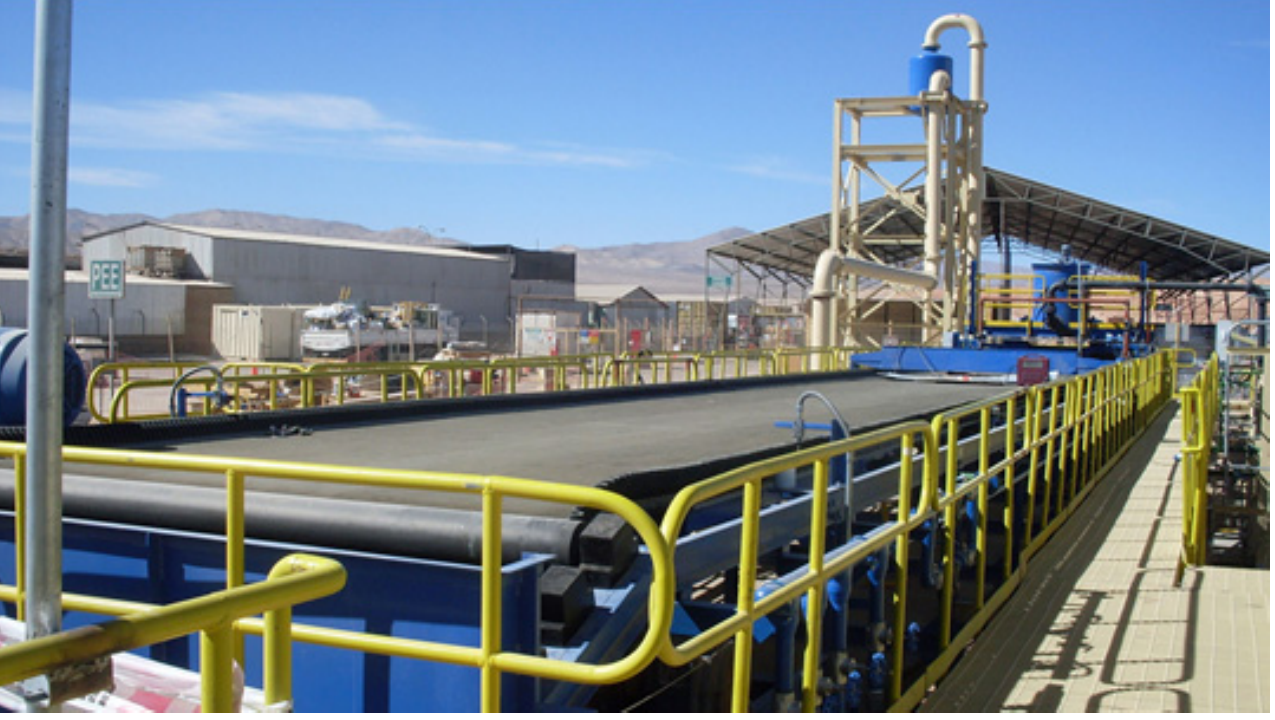
Figure 2. Typical Tailings Horizontal Belt Filter [13].